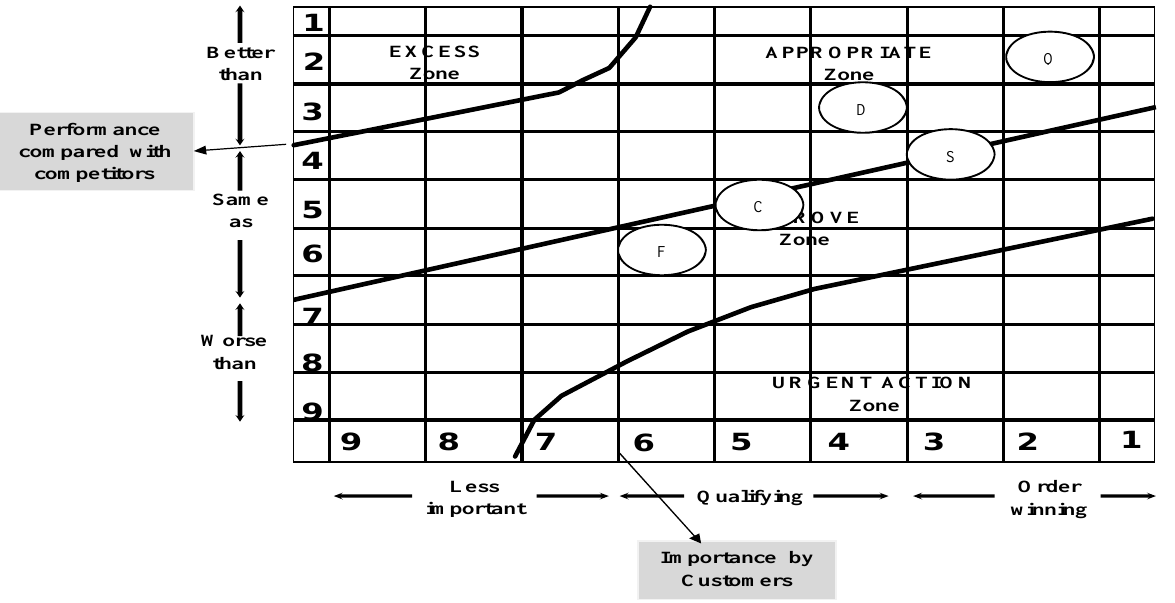
Fig. 2. The Importance-Performance Matrix of firm A